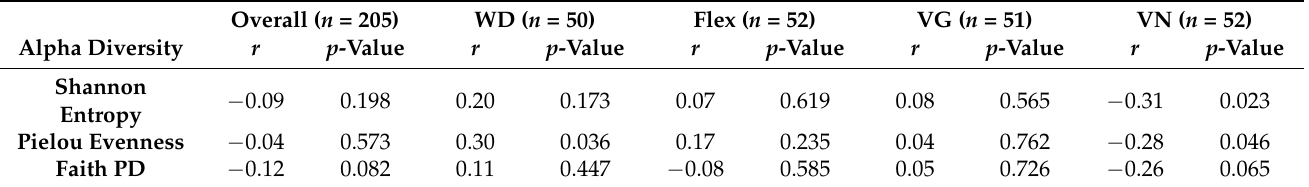
Table 7. Pearson correlation between fiber intake (g/day) and alpha diversity in diet